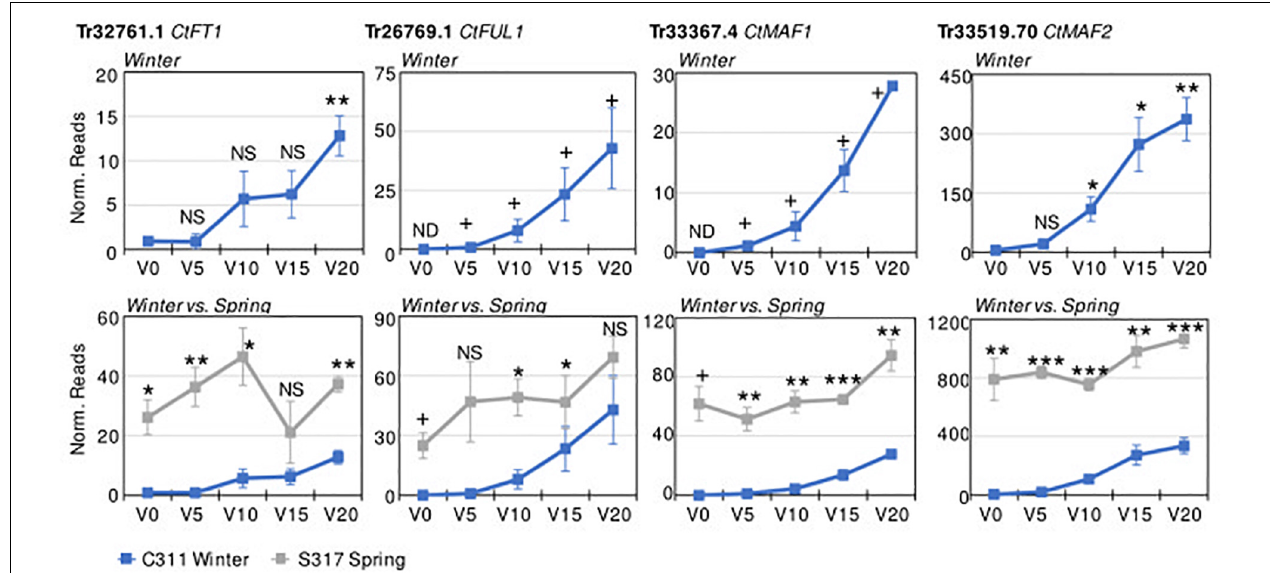
FIGURE 3 | Differential expression of key safflower transcripts with vernalization treatment and genotype. Plotted on the y -axes are the average normalized transcript read counts, from three biological replicates for key transcripts from transcriptomes of non-vernalized plants (V0) or plants that had been vernalized for 5, 10, 15, or 20 days. Data are presented for the winter safflower accession (C311, blue line), showing the impact of increasing durations or vernalization pre-treatment (top row). Then, gene expression in the winter type is contrasted with the spring cultivar (S317, gray line). Error bars show standard error. Statistical tests include Student’s t -test comparison to the non-vernalized control for time course analysis of expression in the winter safflower (when plotted alone) or comparison between the spring versus winter safflower when genotypes are compared (NS, non-significant, * P < 0.05, ** P < 0.01, *** P < 0.001). Expression not detected in some samples (ND), resulting in an absolute or presence/absence contrast